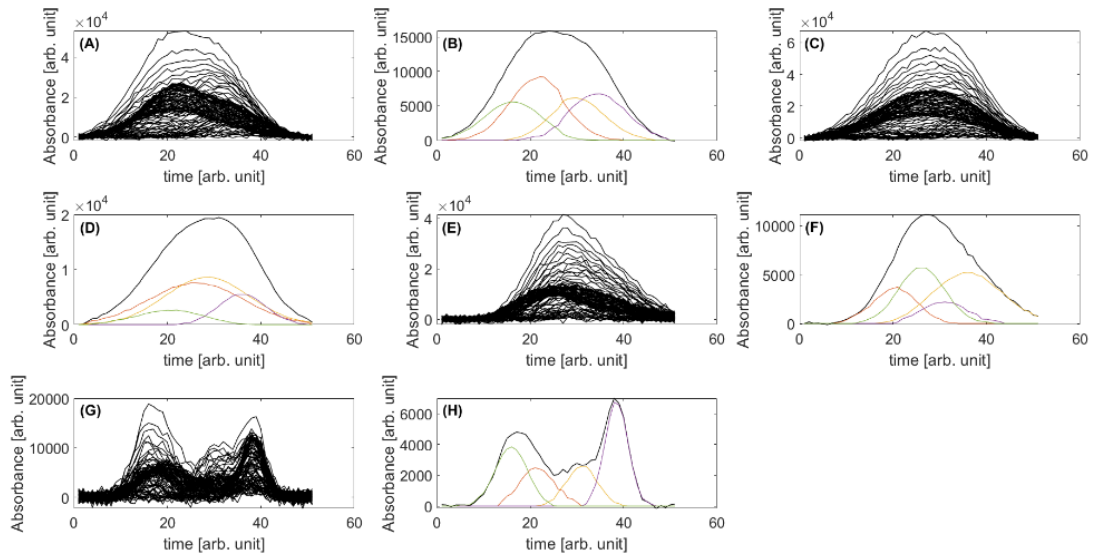
Figure 1. Simulated HPLC-DAD datasets: ( A , C , E , G ) superposition of the signals from all channels for D1nh, D2nh, D3nh and D4nh, respectively; ( B , D , F , H ) profiles for each component for D1nh, D2nh, D3nh and D4nh, respectively. Refer to the Materials and Methods section for additional information.